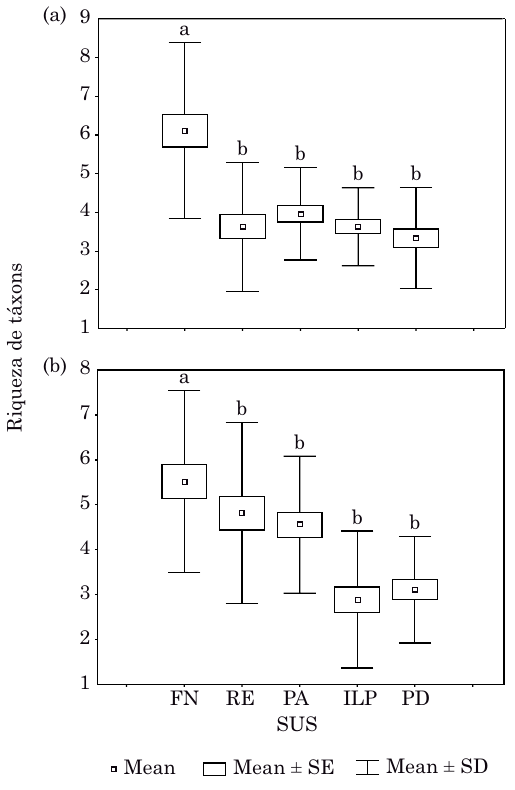
Figura 2. Riqueza de táxons da macrofauna do solo nas áreas de floresta nativa (FN), reflorestamento de eucalipto (RE), pastagem (PA), integração lavoura-pecuária (ILP) e sistema plantio direto (PD), no inverno de 2011 (a), e no verão de 2011/12 (b), na região do Planalto sul-catarinense. Médias seguidas pelas mesmas letras são semelhantes pelo teste Kruskal-Wallis (p<0,05; n =